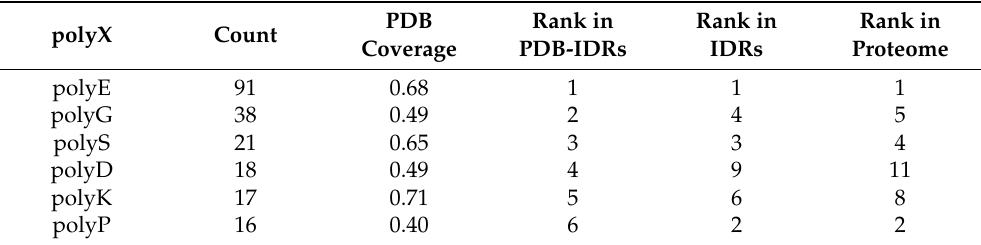
Six most frequent polyXs in IDRs with homology to PDB. See details in Supplementary Tables S4 and S5.